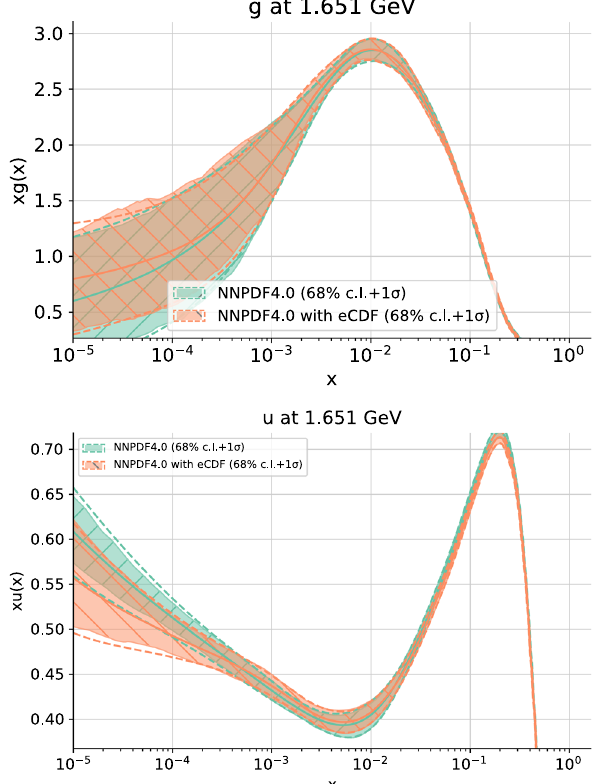
Fig. 4 Comparison between the gluon and up PDFs determined using the NNPDF4.0 methodology (green) and a PDF determined using input scaling based on the eCDF (orange) with all other parameters the